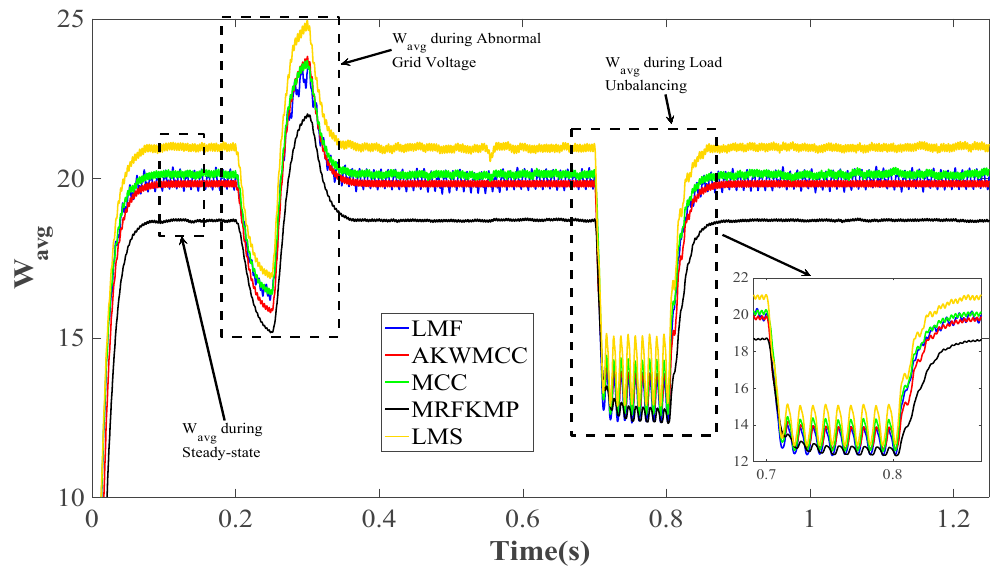
Figure 16. Internal signals analysis (during dynamic conditions) of (cid:2756) (cid:1816)(cid:1801) , (cid:1797) (cid:1816)(cid:1801) , (cid:1797) (cid:1801)(cid:1822)(cid:1807) , (cid:1797) (cid:1790)(cid:1796) , (cid:1797) (cid:1819)(cid:1816) .